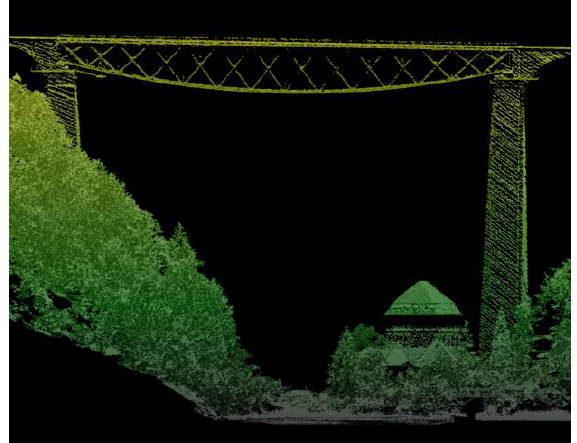
Figure 6: Profile view of a LiDAR point cloud from a Leica TerrainMapper-2, with a conical scan pattern. The result shows the enhanced details on vertical surfaces and even on the structures under the bridge deck.